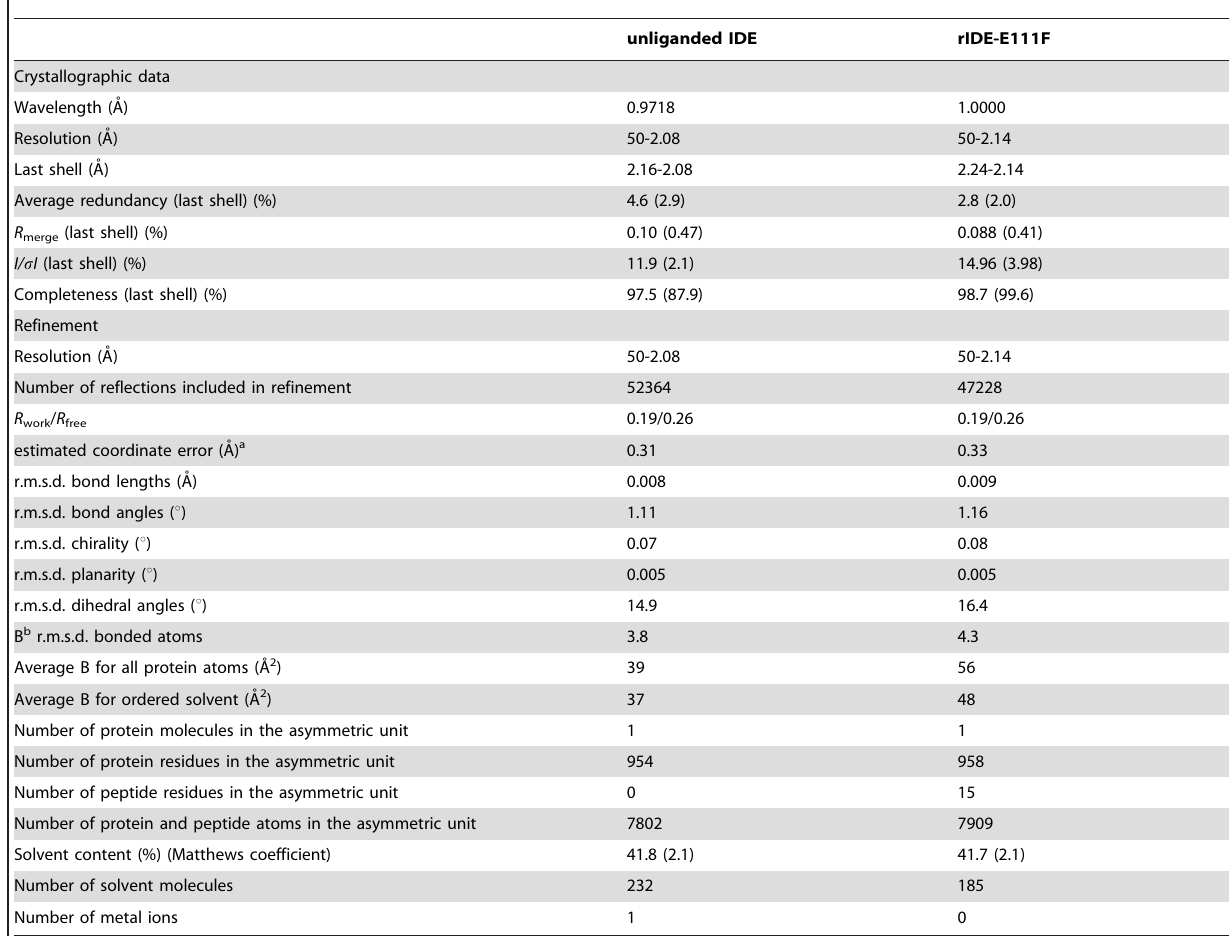
Table 2. Summary of crystallographic data and model